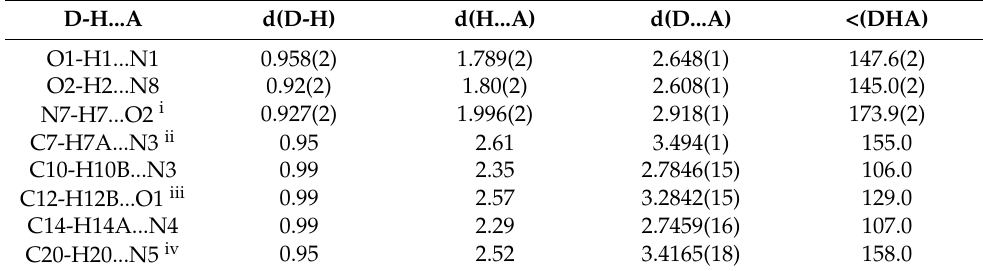
Table 3. Hydrogen bonds for 4 [Å and °].